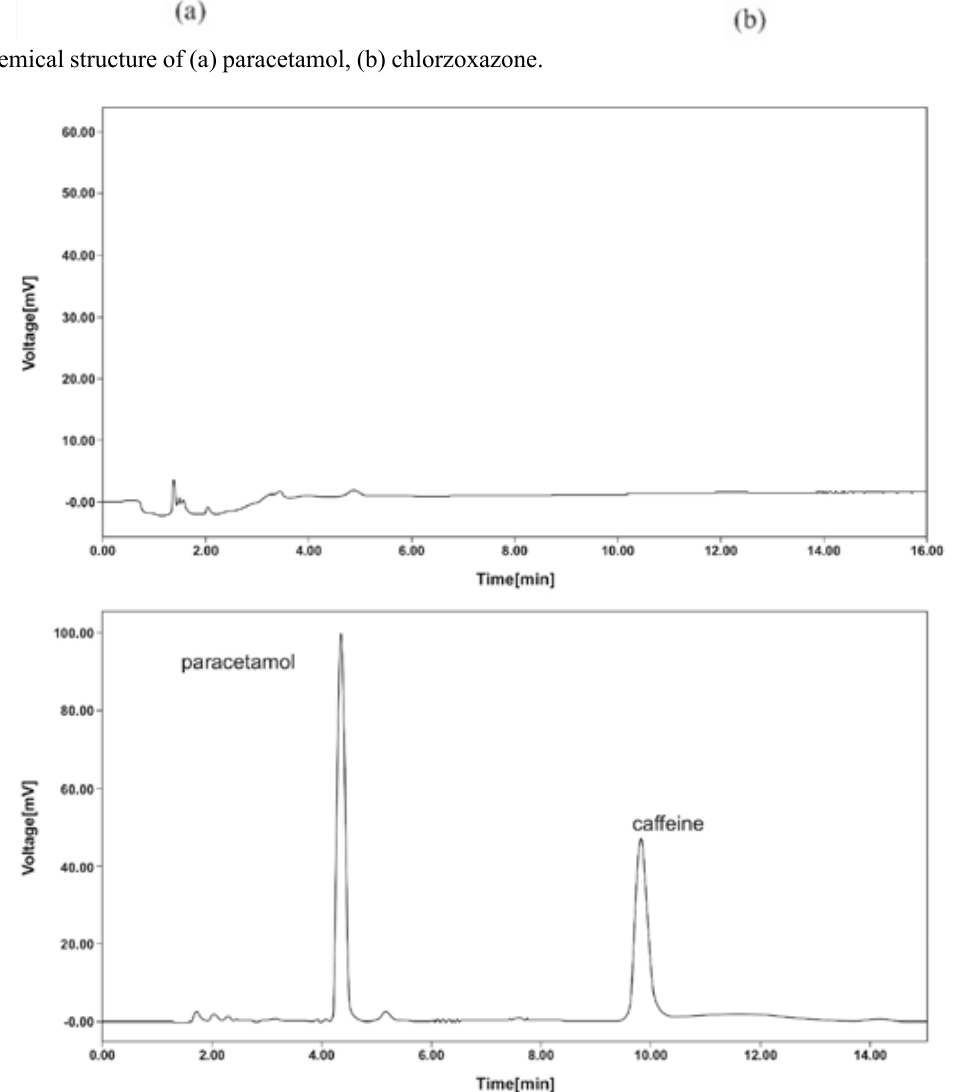
FIGURE 2 - Chromatogram of (a) blank rat ’ s plasma (b) Rat plasma spiked with paracetamol (30 µg/mL) and caffeine (80